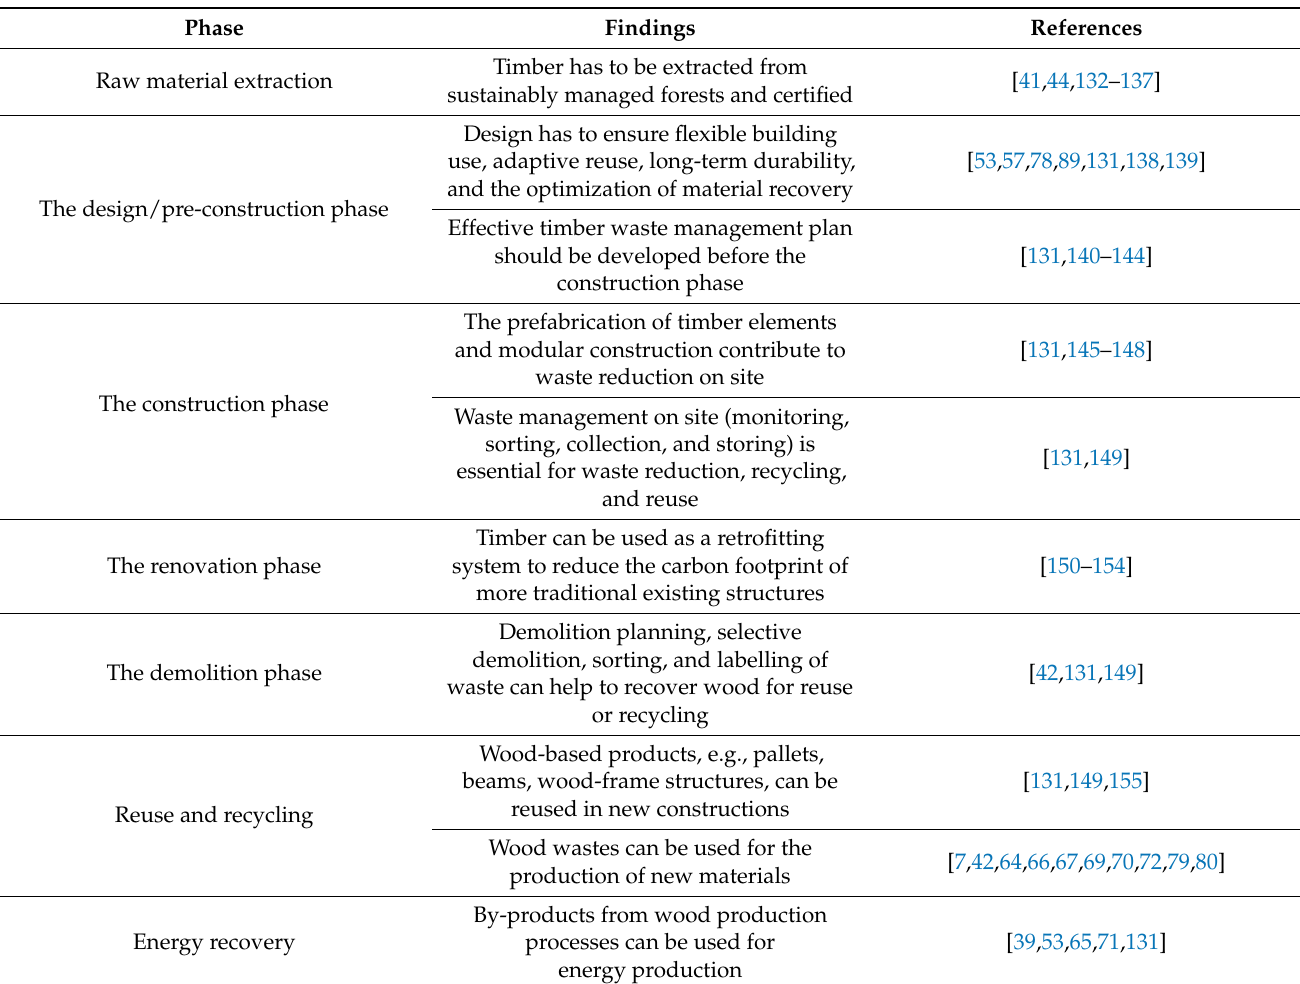
Table 7. Studies on the potential reduction of GHG/CO 2 emissions by increased use of wood in the building